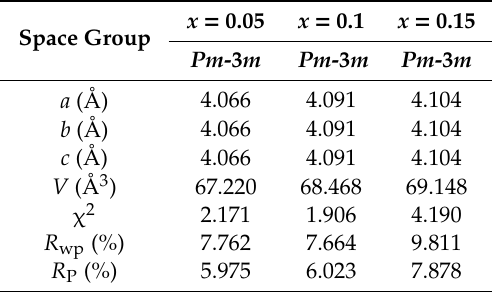
Figure 1. ( a ) Room temperature XRD patterns of BFY x samples and the magnified view of the XRD patterns, 2 θ = 29 to 33 ◦ ; ( b ) Rietveld refinement plot of BFY10 XRD data; ( c ) XRD patterns of BFY x -CGO composites fired at 1000 ◦ C for 12 h. Table 1. Lattice parameters of BFY x samples.